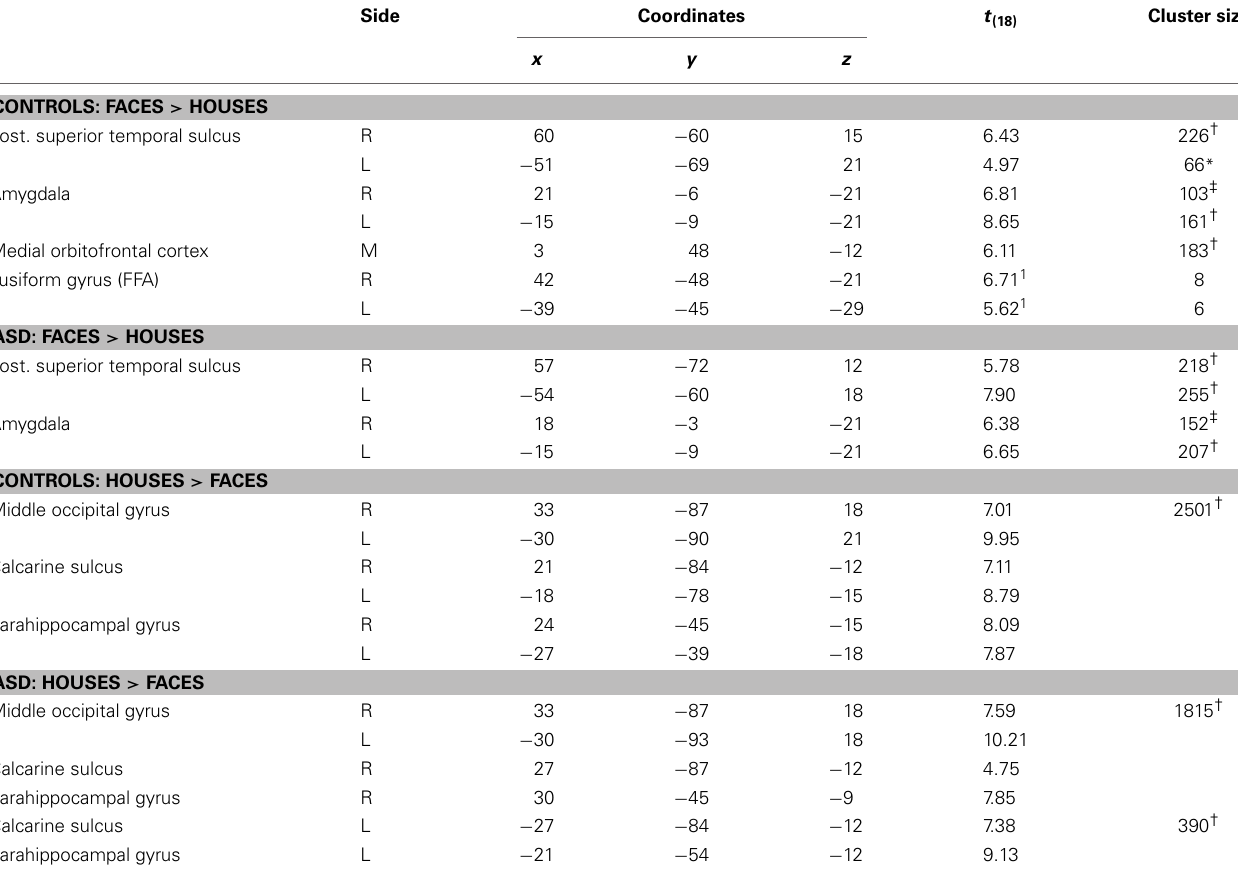
Table 2 | fMRI analysis: face